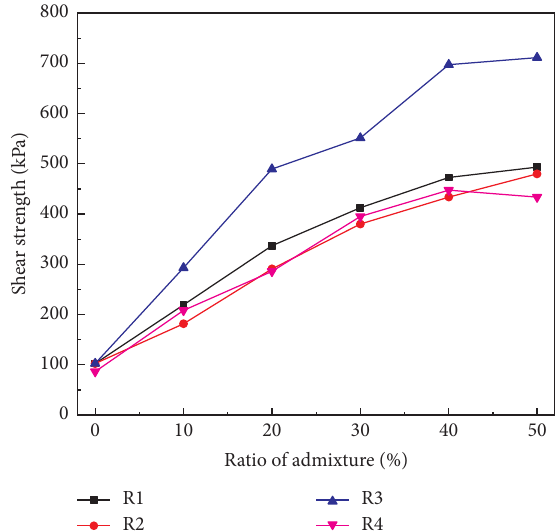
Figure 8: Variation of shear strength for test groups.